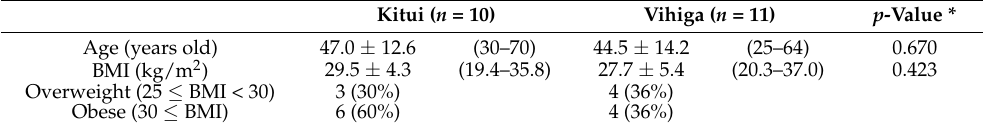
Table 1. The characteristics of participants (farm women in charge of meal